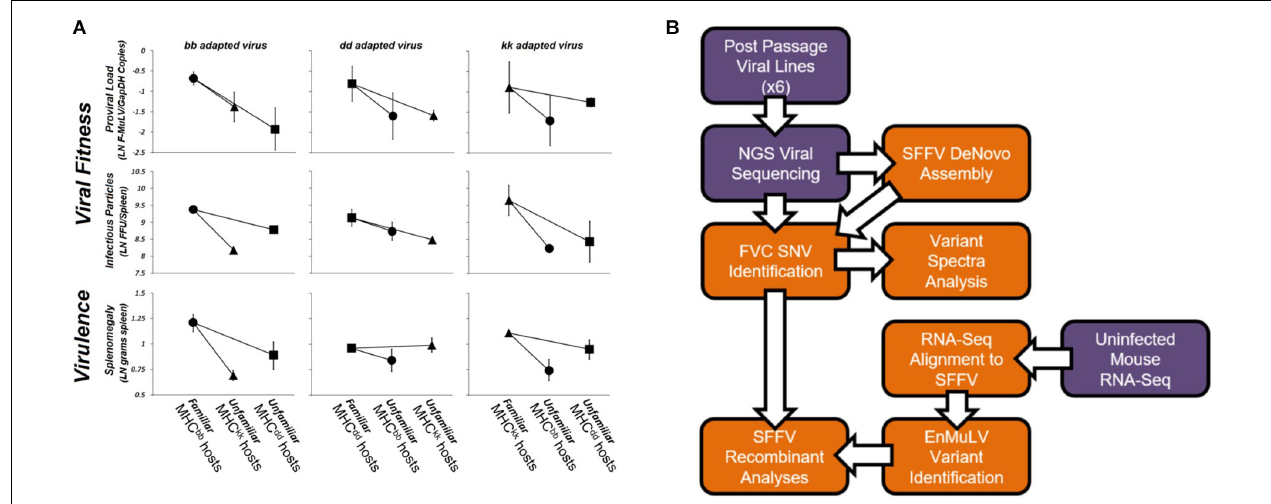
FIGURE 1 | Friend virus complex adapted to a specific MHC genotype and study workflow. Passaged FVC shows strong fitness and virulence tradeoffs when infecting unfamiliar (novel) host genotypes (A) . Symbols reflect host genotypes (circle = MHC bb hosts, square = MHC dd hosts, triangle = MHC kk hosts) and represent the log transformed least square (LS) means of two replicate tests (error bars represent the range of means for each test). Comparisons of patterns of pathogen fitness and virulence between virus stocks (denoted bb passaged virus, dd passaged virus, and kk passaged virus) across the three host genotypes shows that pathogen fitness and virulence is host genotype-specific with tradeoffs in the ability of virus adapted to one MHC to productively infect and cause virulent disease in other (unfamiliar) host MHC genotypes. Viral fitness (12 of 12 comparisons) and disease virulence (5 of 6 comparisons) are higher when a passaged virus stock is exposed to a familiar (i.e., its host genotype-of-passage) versus an unfamiliar MHC genotype (i.e., a genotype the virus hasn’t been passaged through). Data are shown on a natural-log scale. Adapted from Kubinak et al. (2012). The bioinformatics workflow used in the present study is diagramed in (B) . Sample or data inputs are depicted in purple while computational steps are shown in orange. Arrows show workflow